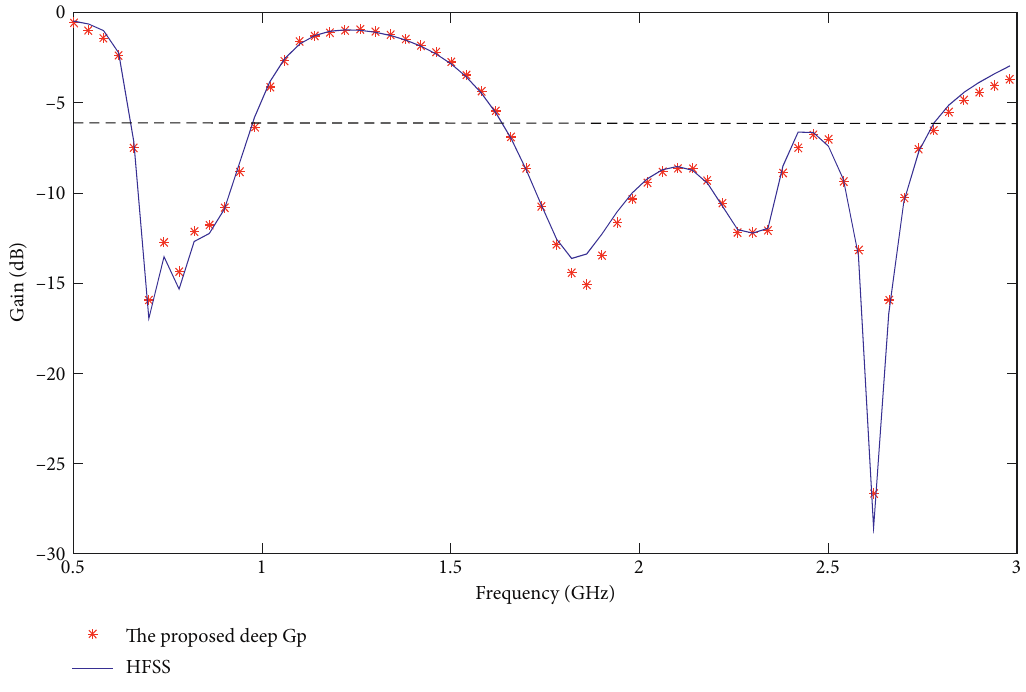
Figure 6: S 11 comparison results of the multiband microstrip